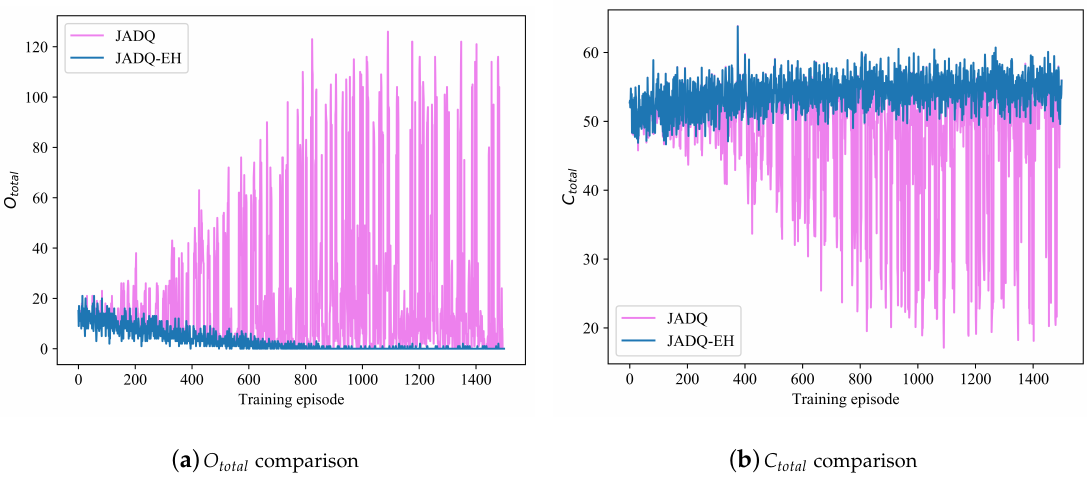
Figure 11. Performance comparison between JADQ-EH and JADQ about O total and C total under scenario 2. Table 9. Performance comparison between JADQ-EH and JADQ about O ave